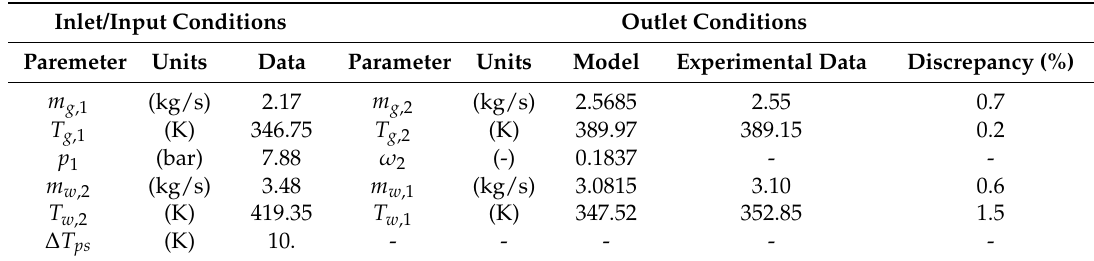
Table A1. Validation of the saturator model against experimental data from Lindquist et al. [17]. Inlet/Input Conditions Outlet Conditions Paremeter